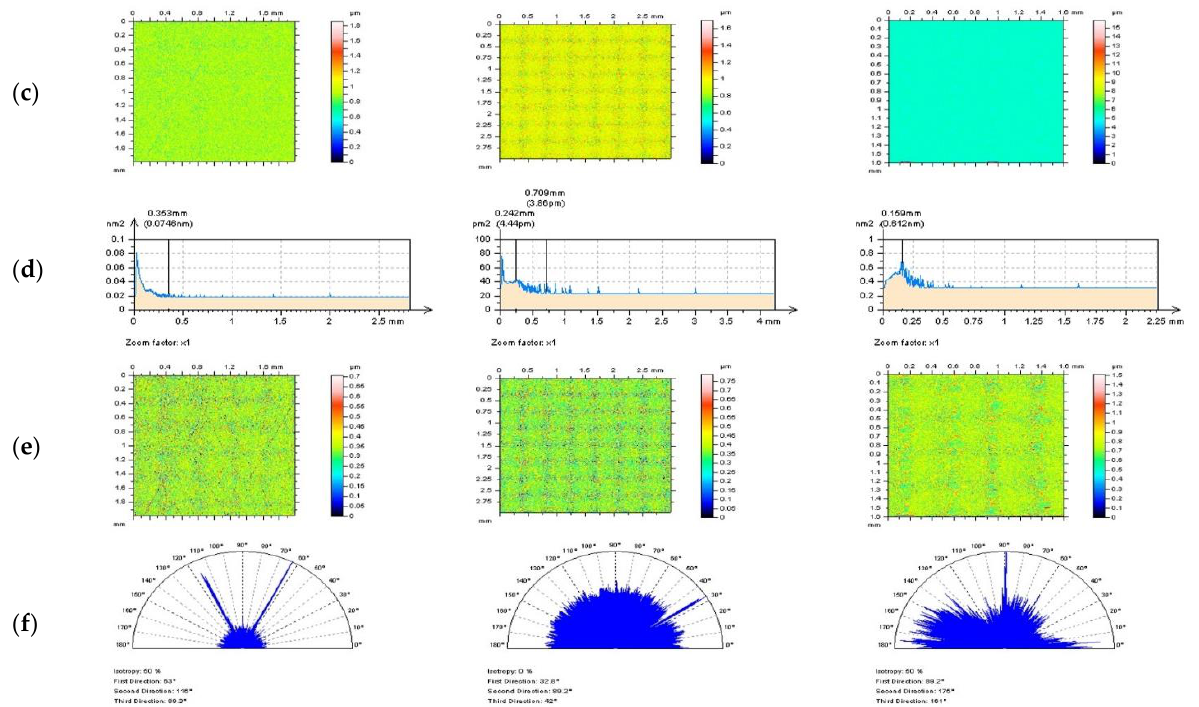
Figure 11. Defined for plateau-honed cylinder liner (left column), milled (center), and laser-textured (right column) surfaces: contour map plots of detail after DGS-F (cut-off = 0.025 mm) noise reduction ( a ) with selected surface topography parameters ( b ), correspondingly, received S-surface ( c ) with their PSDs ( d ), respectively, and S-surfaces after thresholding (0.13–99.87%) method ( e ) with their texture direction graphs ( f ) appropriately.